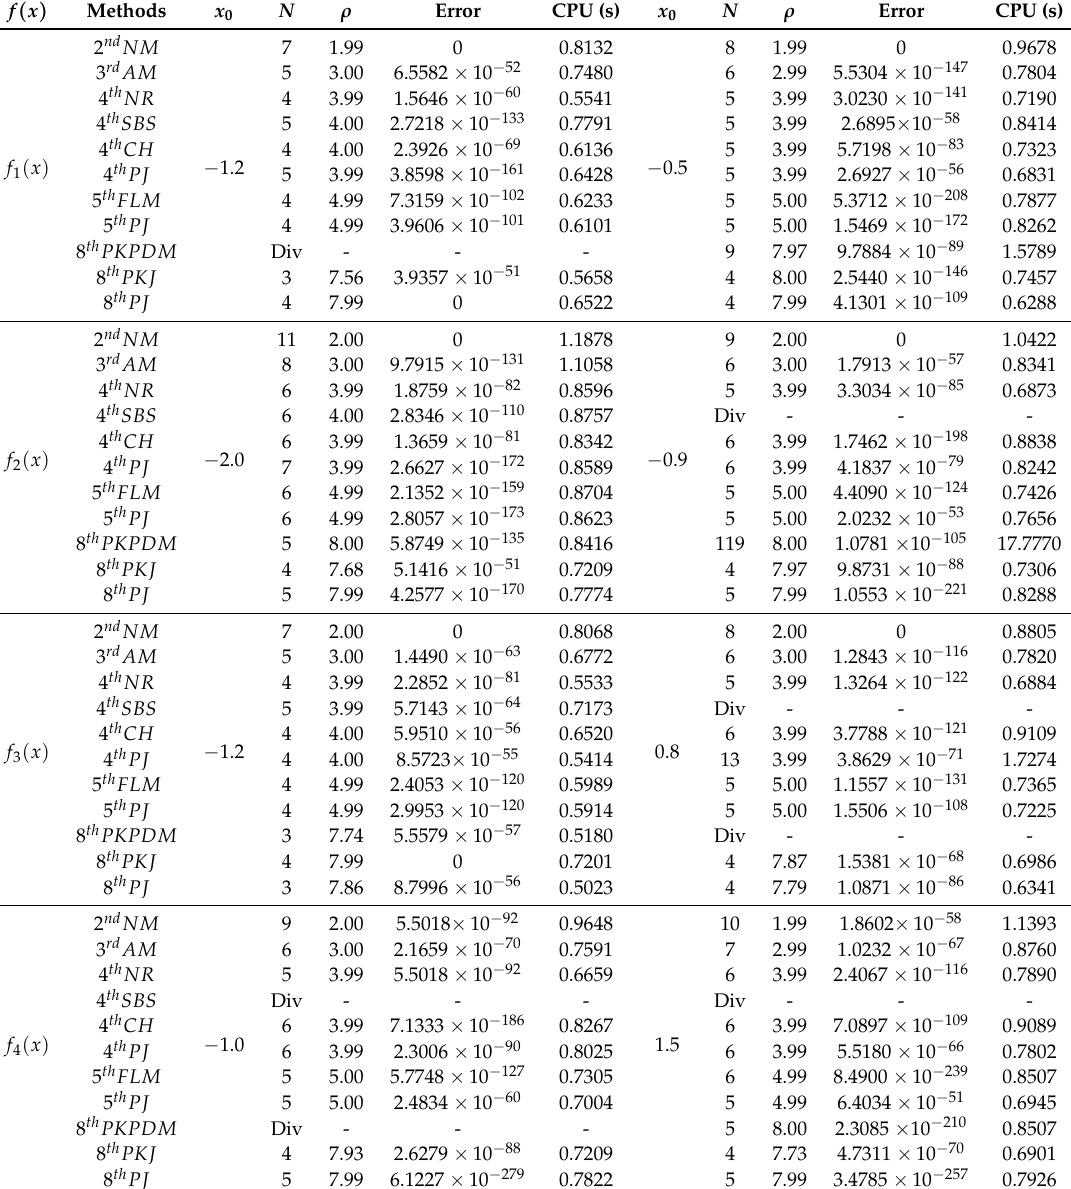
Table 2. Numerical results for test